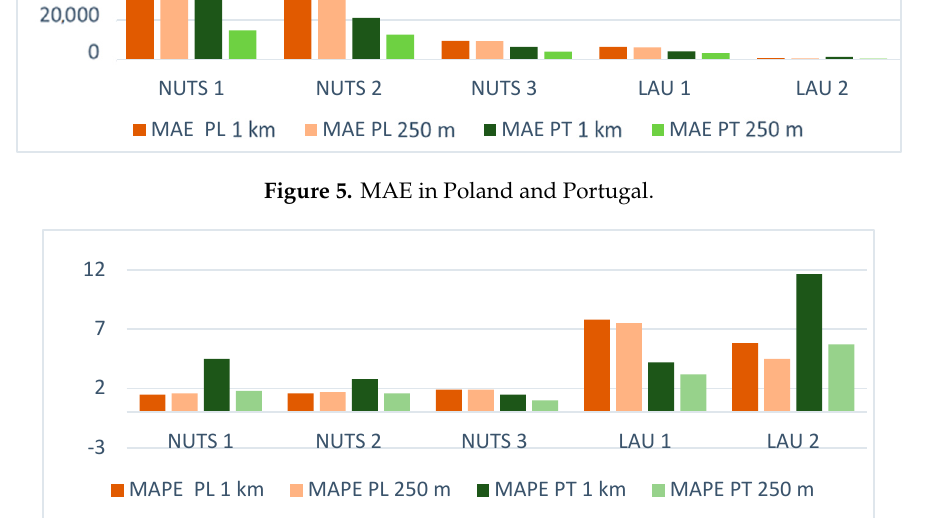
Figure 5. MAE in Poland and Portugal.